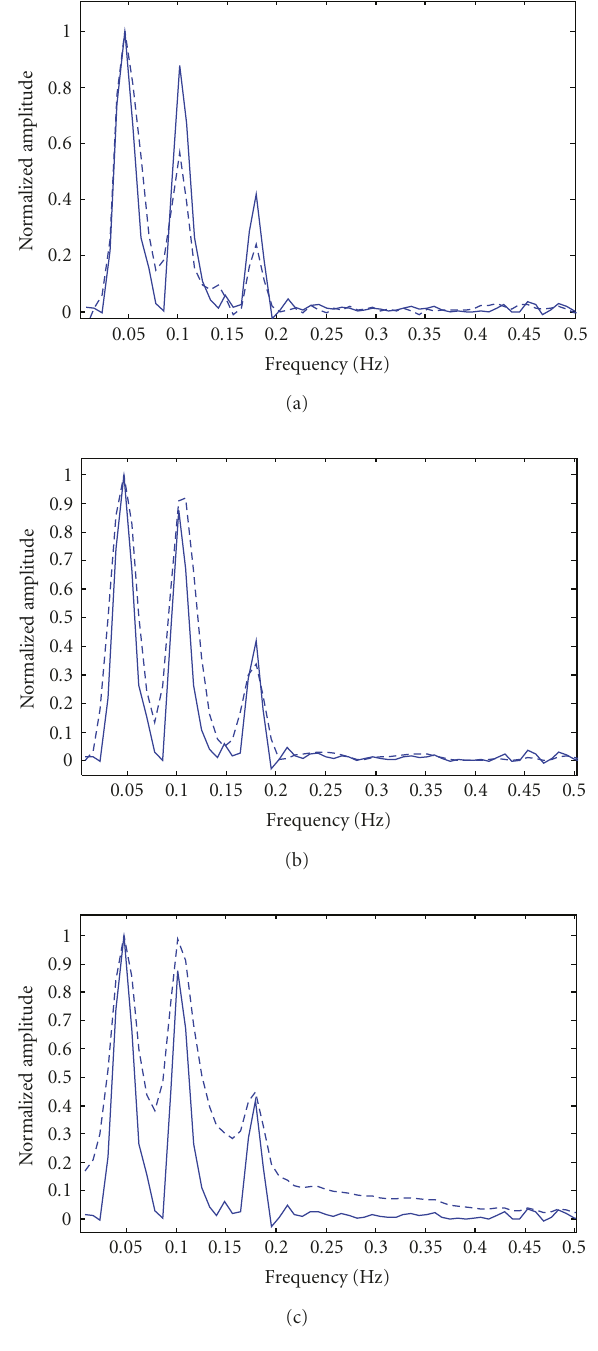
Figure 4: Normalized slices (dashed) of (a) SPWVD; (b) SP; and (c) CWD. All plots are compared against the MBD (solid).